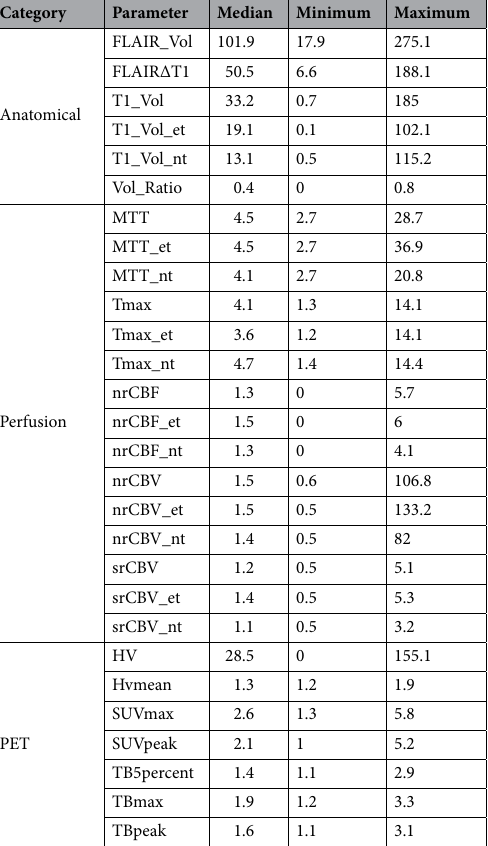
Table 2. The Median, Min and Max of imaging parameters on baseline imaging (n = 33). T1_Vol : Tumor volume on post T1 weighted image, T1_Vol_et : enhancing tumor volume, T1_Vol_nt : necrotic tumor tissue volume on post T1 weighted image, srCBV : the mean value within T1_Vol, srCBV_et : the mean value within T1_Vol_et, srCBV_nt : the mean value within T1_Vol_nt, FLAIRΔT1 : FLAIR_Vol - T1_Vol, Vol_Ratio : T1_Vol/